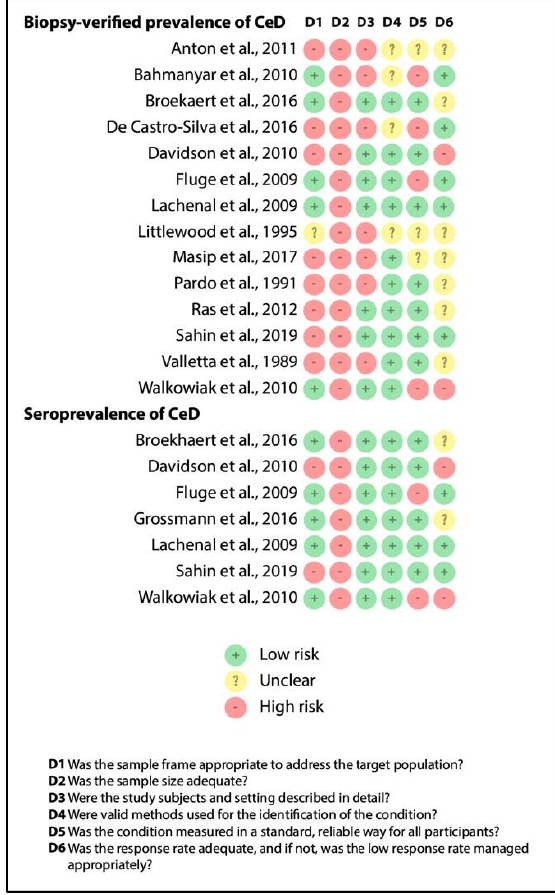
Figure 4. Result of the risk of bias assessment (CeD: celiac disease).